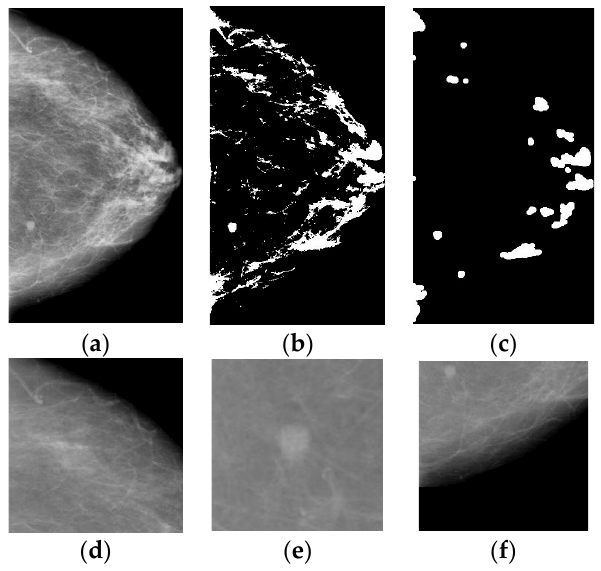
Figure 2 . GFCM acquisition and patch extraction. ( a ) Enhanced breast image. ( b ) Binarized GFCM. ( c ) Binarized GFCM after the opening operation. ( d ) Extracted breast tissue patch. ( e ) Extracted breast mass patch that centers on the mass. ( f ) Extracted breast mass patch that contains mass.